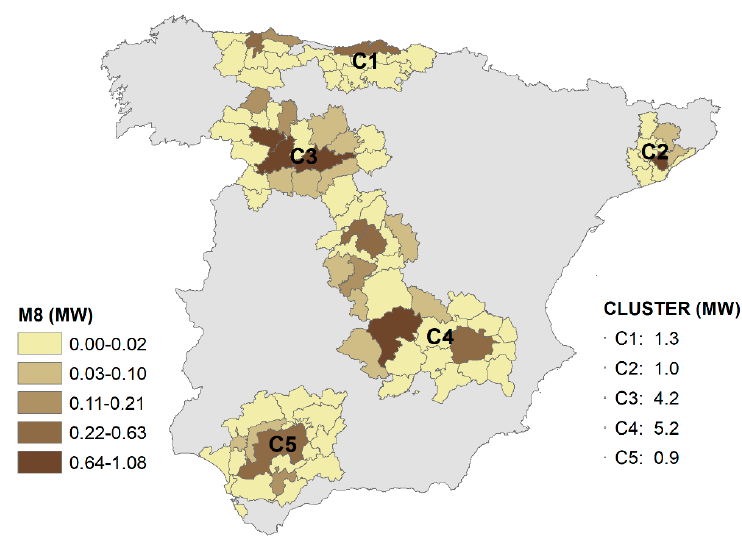
Figure 8. Geographical distribution of the power potential and clusters’ power for mixture M8.